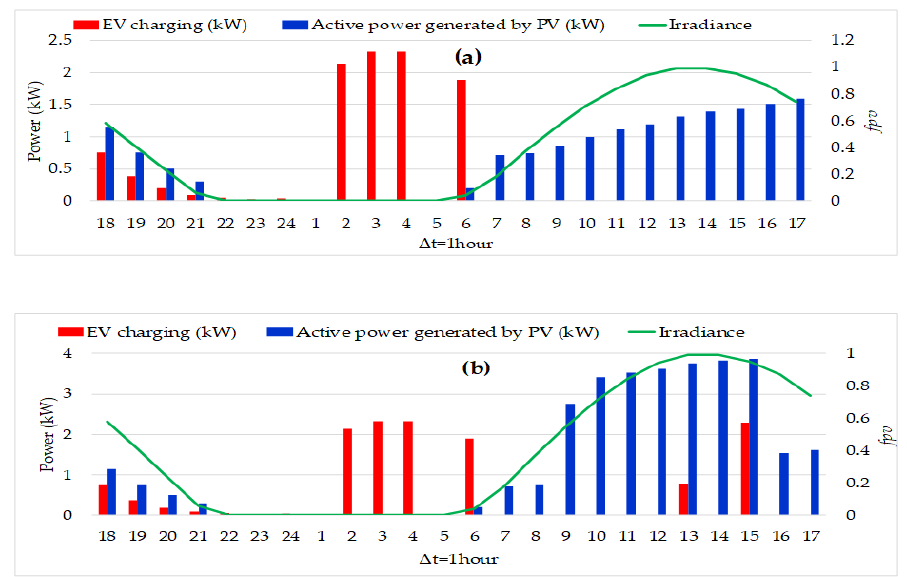
Figure 9. Comparison of the generated power by (PVs) vs consumed power by (EVs). ( a ) on a weekday. ( b ) on weekend.